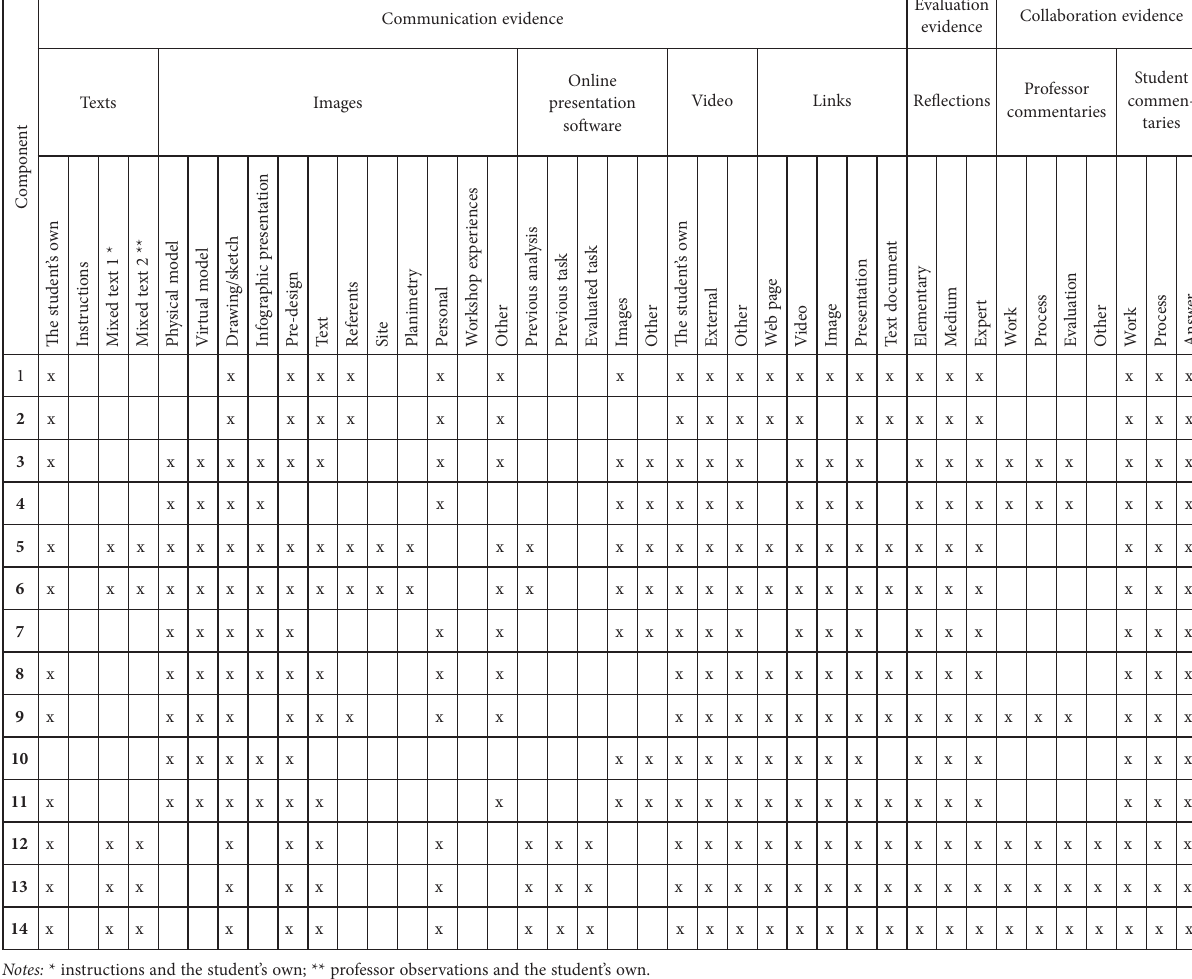
Communication evidence